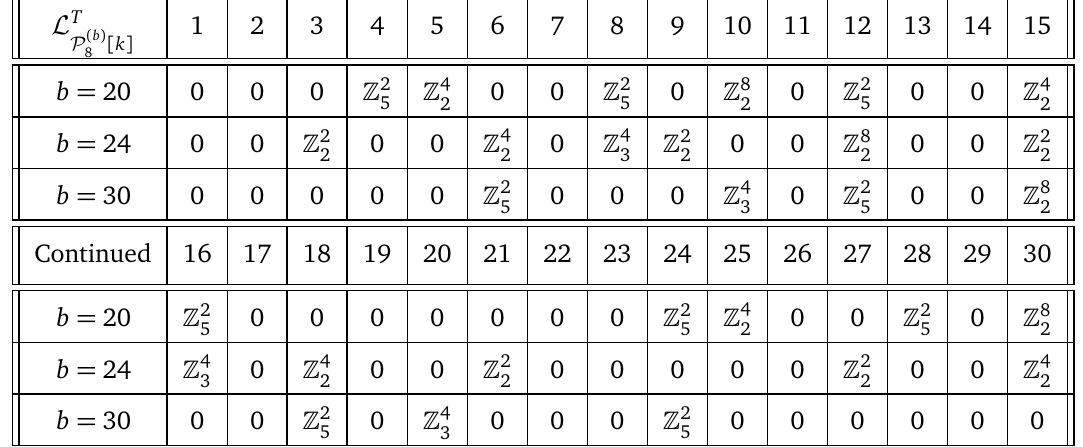
Table 13: Trapped defect groups for untwisted punctures P N = ( 2,0 ) theory. The columns parametrize different values of k . The results can be extended beyond this table as they only depend on k ( mod b )